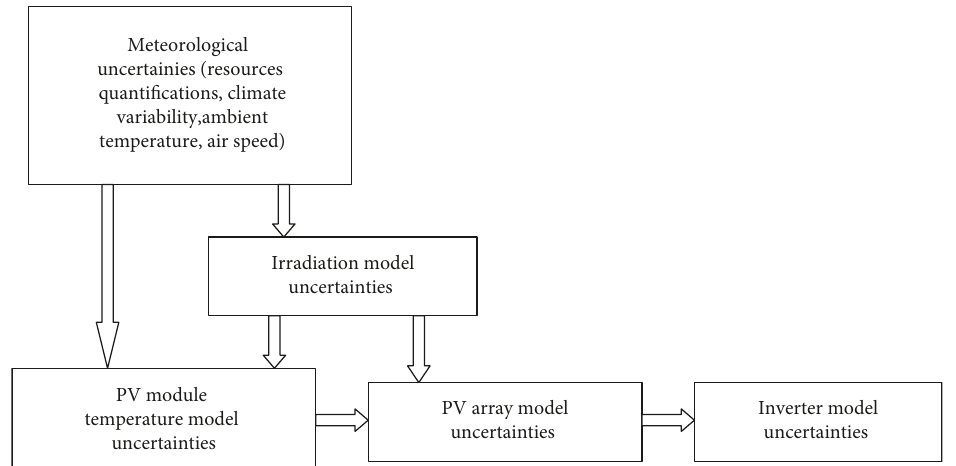
Figure 1: Di ff erent steps in the PV modeling